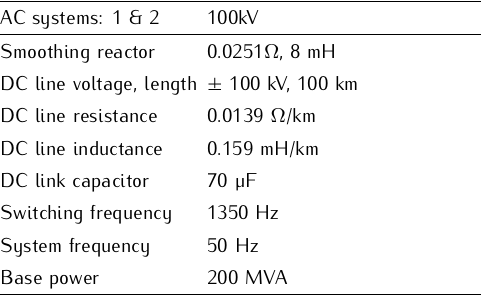
Table 3. Parameters of the studied system.